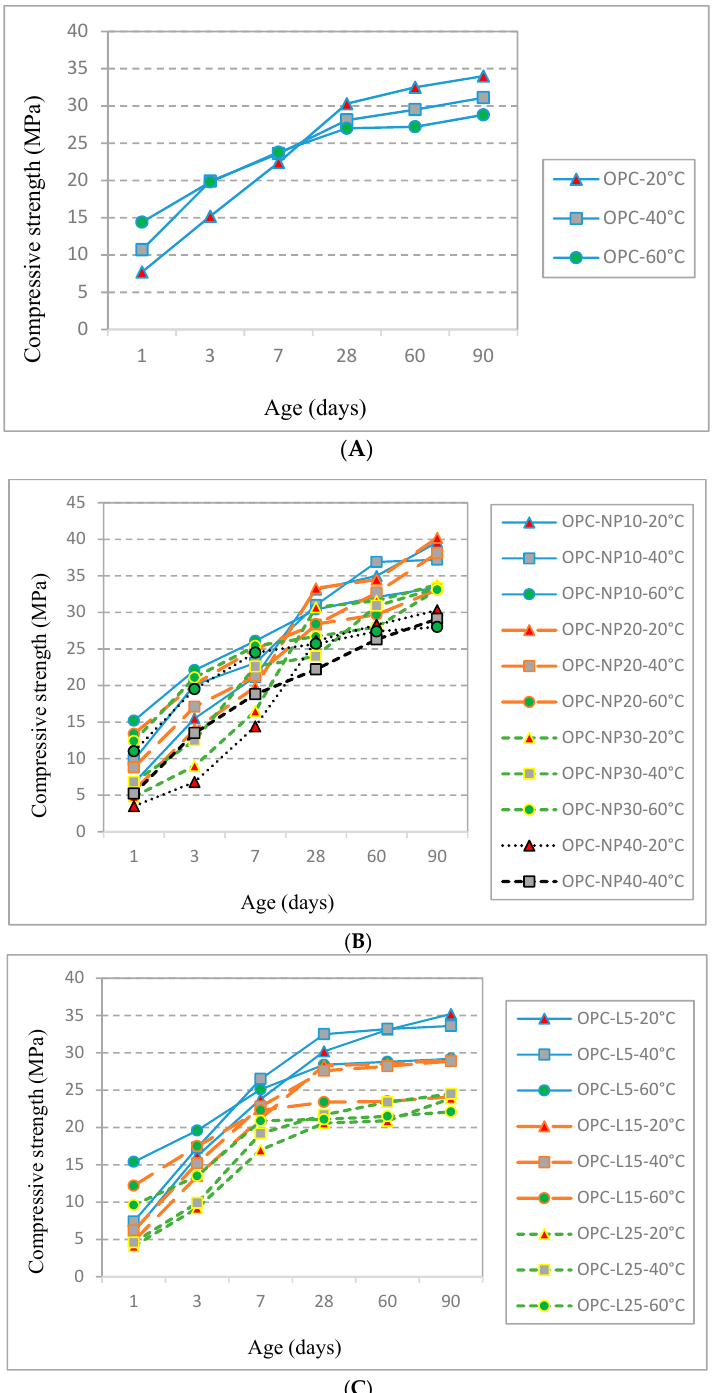
Figure 8. Compressive strength (MPa) at various water curing temperatures and ages for ( A ) OPC; ( B ) natural pozzolan blended cement; ( C ) limestone powder blended cement mortars